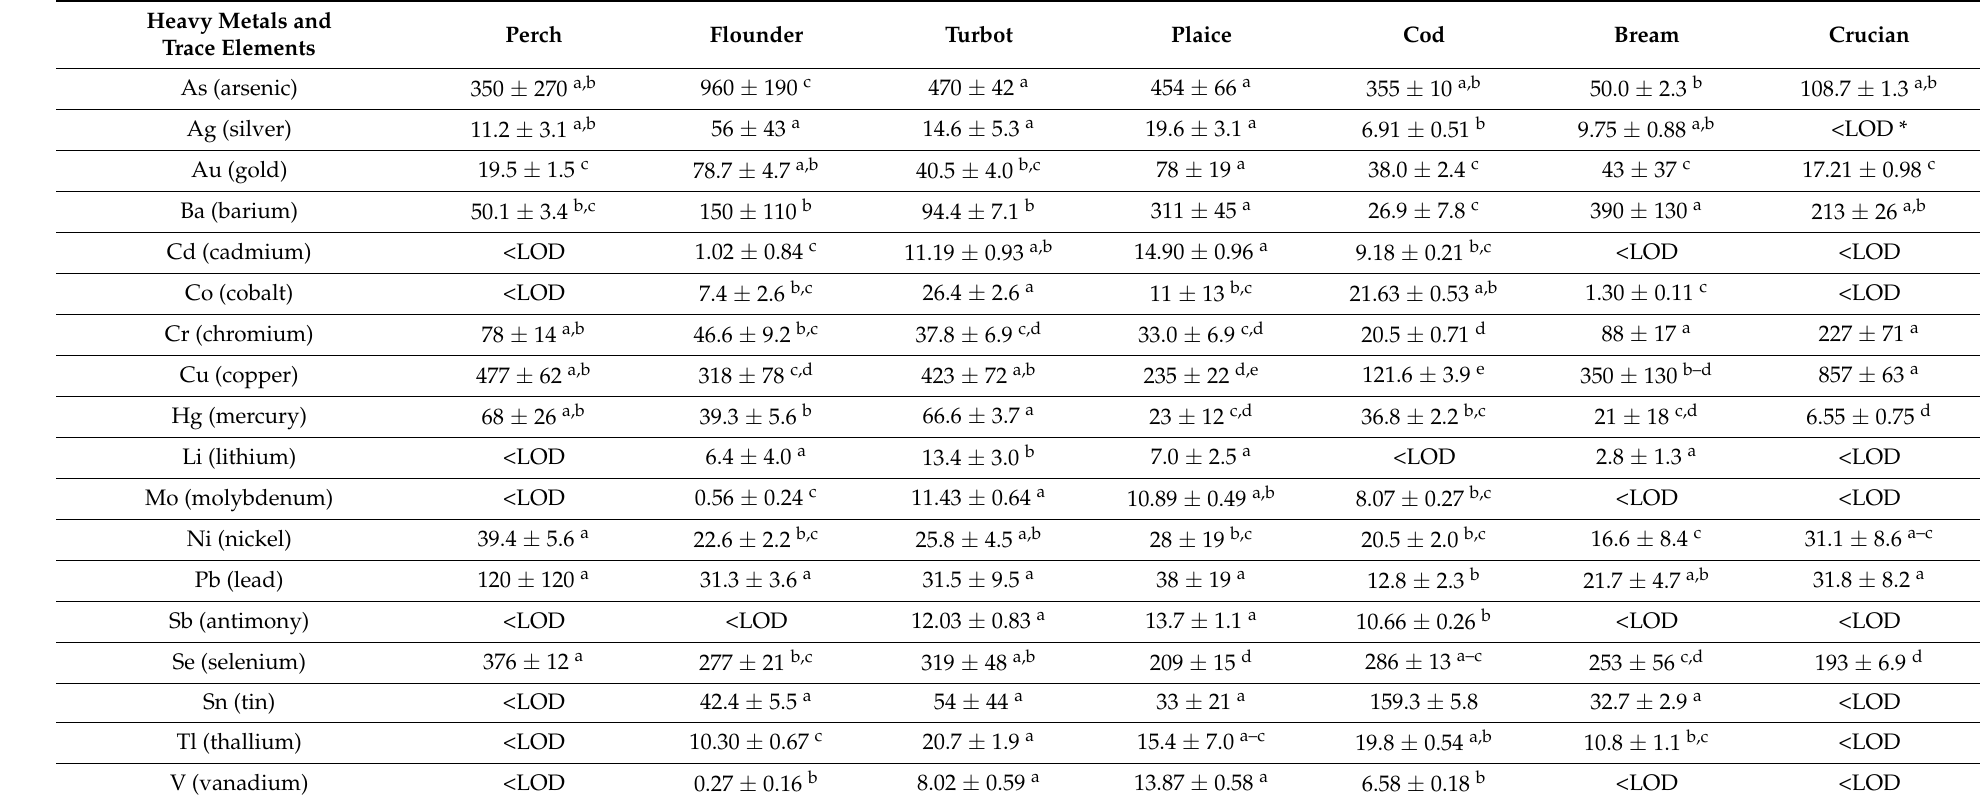
Table 3. The levels of heavy metals and trace elements in the fish muscle of fish species (mean ± SD) ( µ